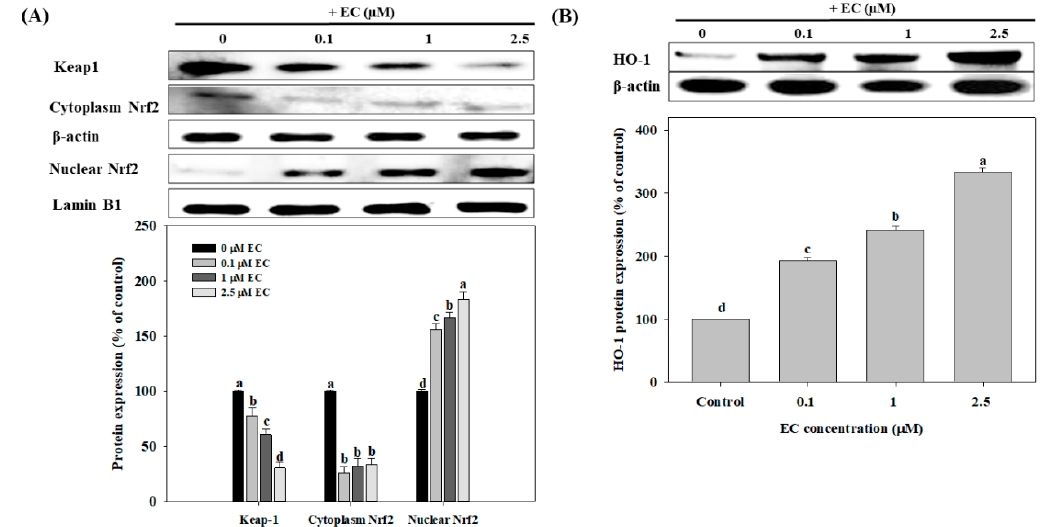
Figure 6. Effects of erinacine C (EC) on Nrf2, Keap-1 ( A ), and HO-1 ( B ) protein expression in BV2 microglial cells. Cells were treated with different concentrations (0.1–2.5 µM) of EC for 24 h. Nrf2, Keap-1, and HO-1 protein expressions were determined by western blot analyses. Values (means ± SD, n = 3) not sharing a common lower case letter are significantly different ( p < 0.05). The western blot image is provided as a representative result of multiple experiments.